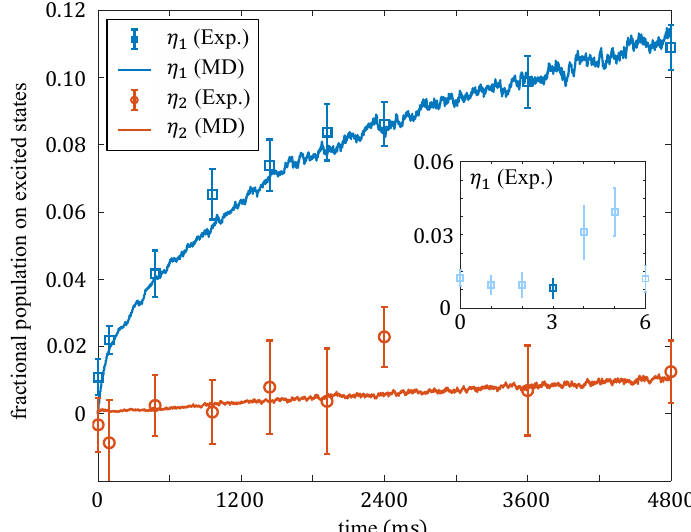
Figure 9: Fractional populations of atoms in the first (open squares) and second (open circles) transversely excited states versus evolution time ( N = 130). The error bars denote the standard deviation of five measurements. The solid curves with corresponding colors show the results of the molecular dynamics (MD) simulations. The insert shows the measurements in the first 6ms after the Bragg pulses, where the darker blue data point (measured at t = 3ms) reflects the most credible in-trap